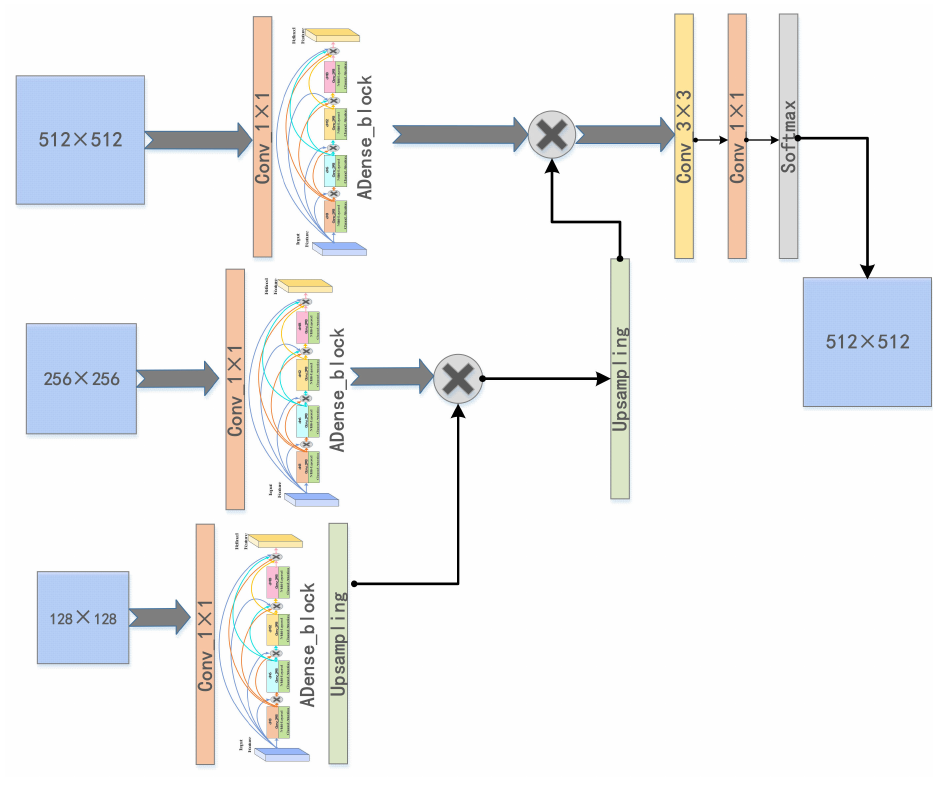
Figure 2. The specified structure of the ADenseNet network.